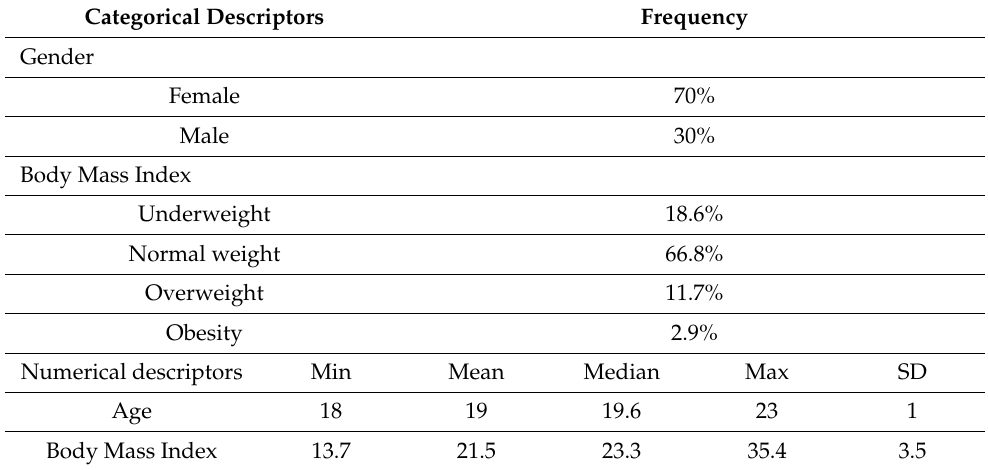
Table 2. Descriptive statistics of the sample.